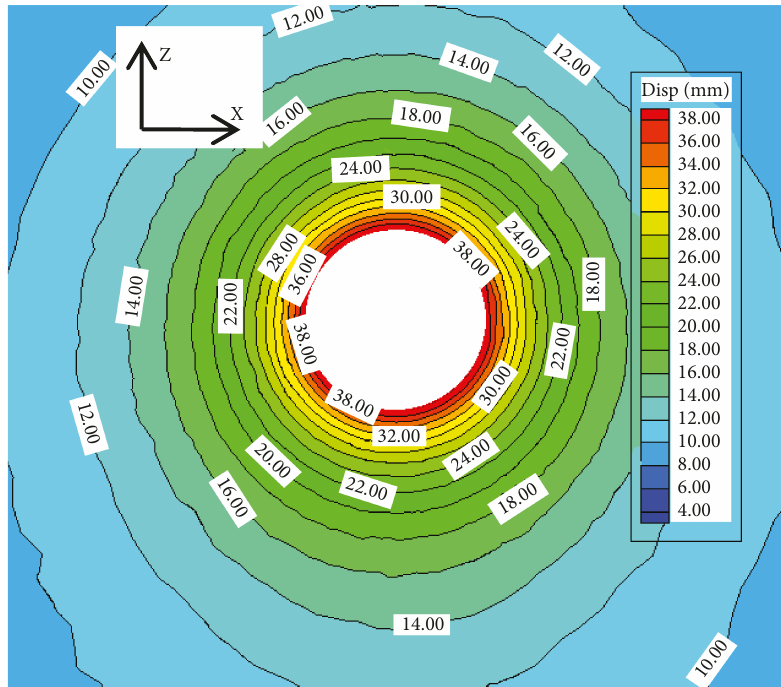
Figure 28: Resultant displacement of section D-D.